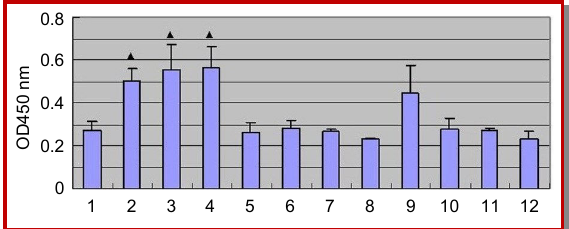
Figure 1: Effects of SCF and imatinib on NHEM proliferation (4 hours after addition of cell count kit 8 reagent). 1: Control group; 2:10 ng/mL SCF; 3:20 ng/mL SCF; 4.5 ng/mL SCF; 5. .1 µM imatinib; 6.1.0 µM imatinib; 7.5.0 µM imatinib; 8.10.0 µM imatinib; 9.5 ng/mL SCF + 0.1 µM imatinib; 10.5 ng/mL SCF + 1.0 µM imatinib; 11.5 ng/mL SCF + 5.0 µM imatinib; 12.5